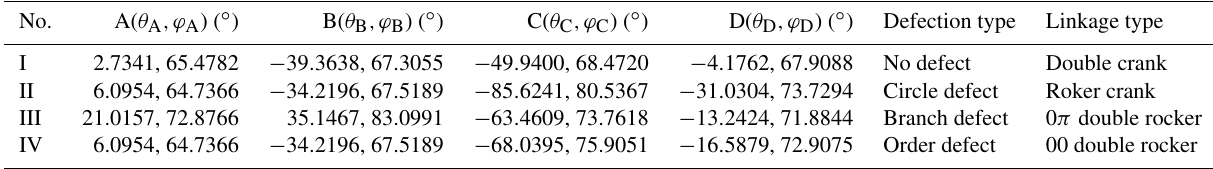
Table 3. Solutions information.